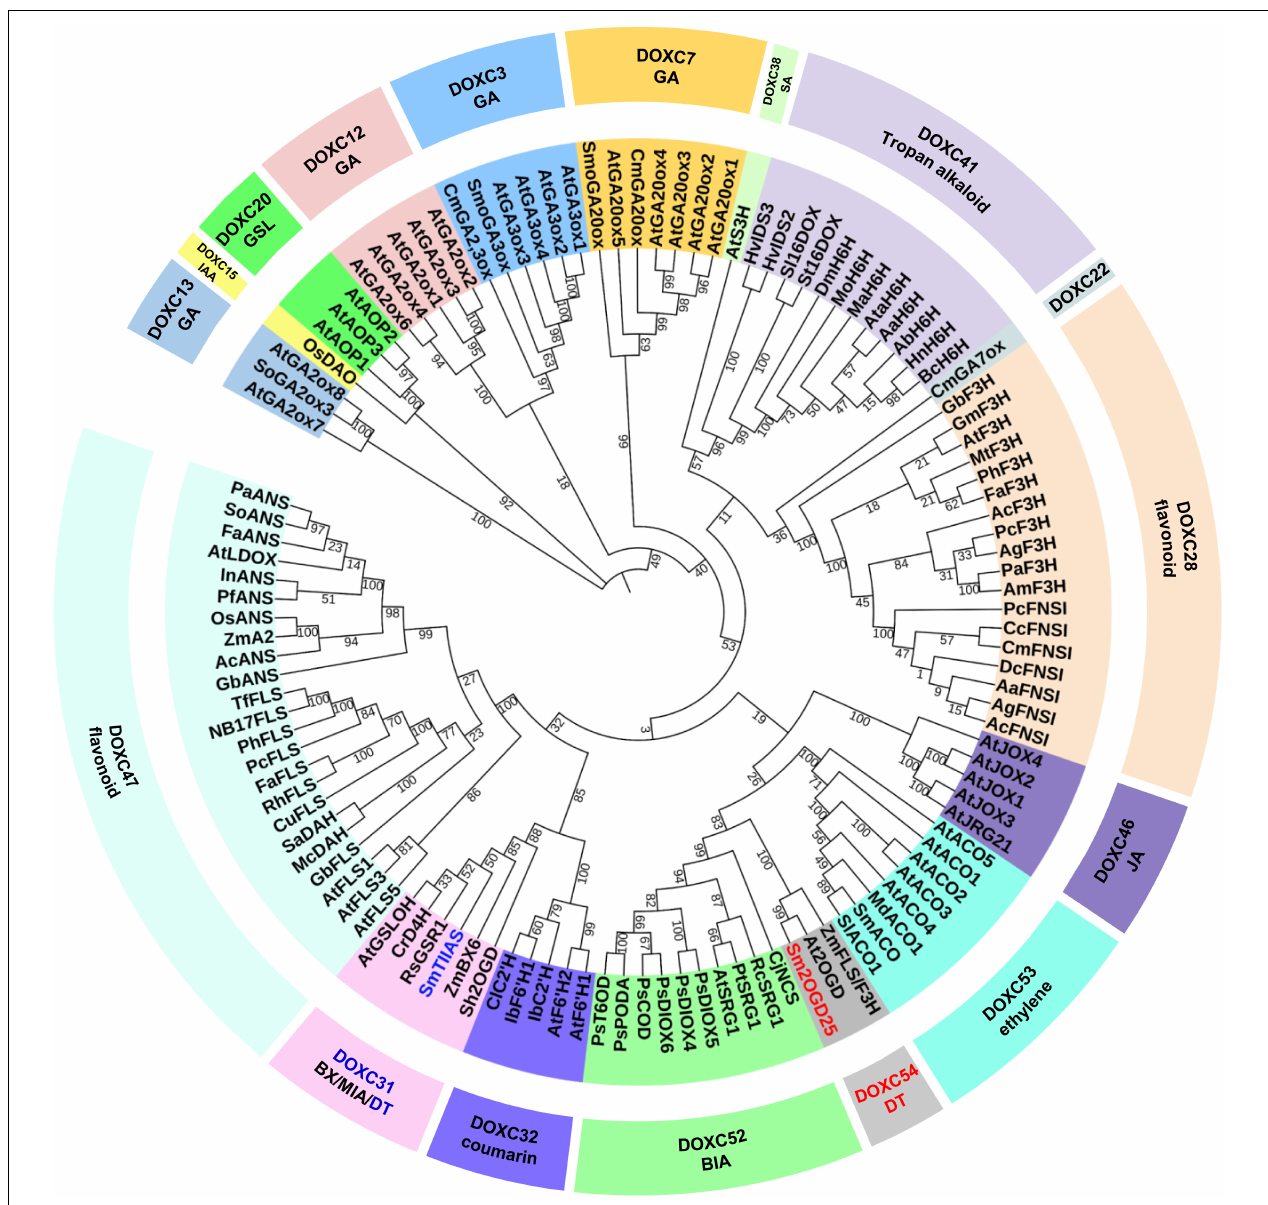
FIGURE 4 | Phylogenetic tree analysis of Sm2OGD25 and other DOXCs. The accession numbers of sequences used in this study are shown in Supplementary Table 5 . GA, gibberellin; IAA, indole-3-acetic acid; GSL, glucosinolate; SA, salicylic acid; JA, jasmonic acid; DT, diterpenoid; BIA, benzylisoquinoline alkaloid; BX, benzoxazinoid; MIA, monoterpenoid indole alkaloid.